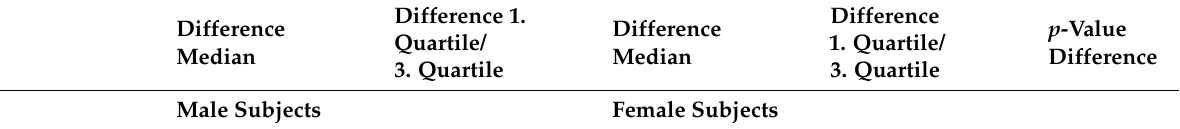
Table 3. Differences between habitual occlusion and splint (median, 1st and 3rd quartiles) of all parameters for men and women as well as the p -value of the comparison between the men and women. Significant p -values are marked in bold following Bonferroni-Holm